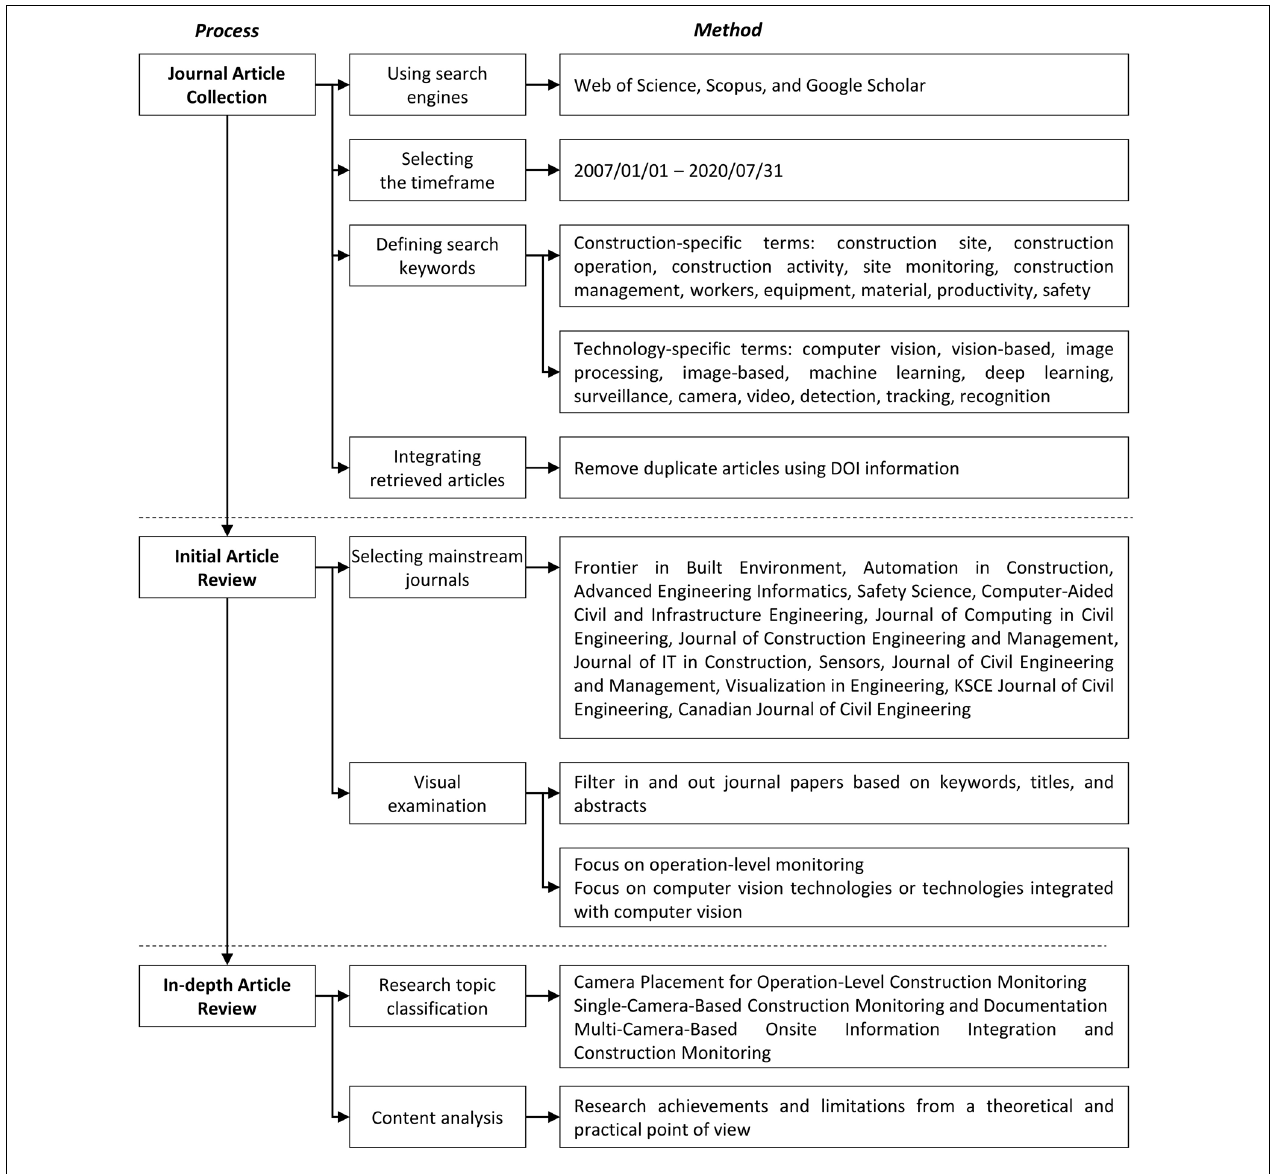
FIGURE 3 | Research